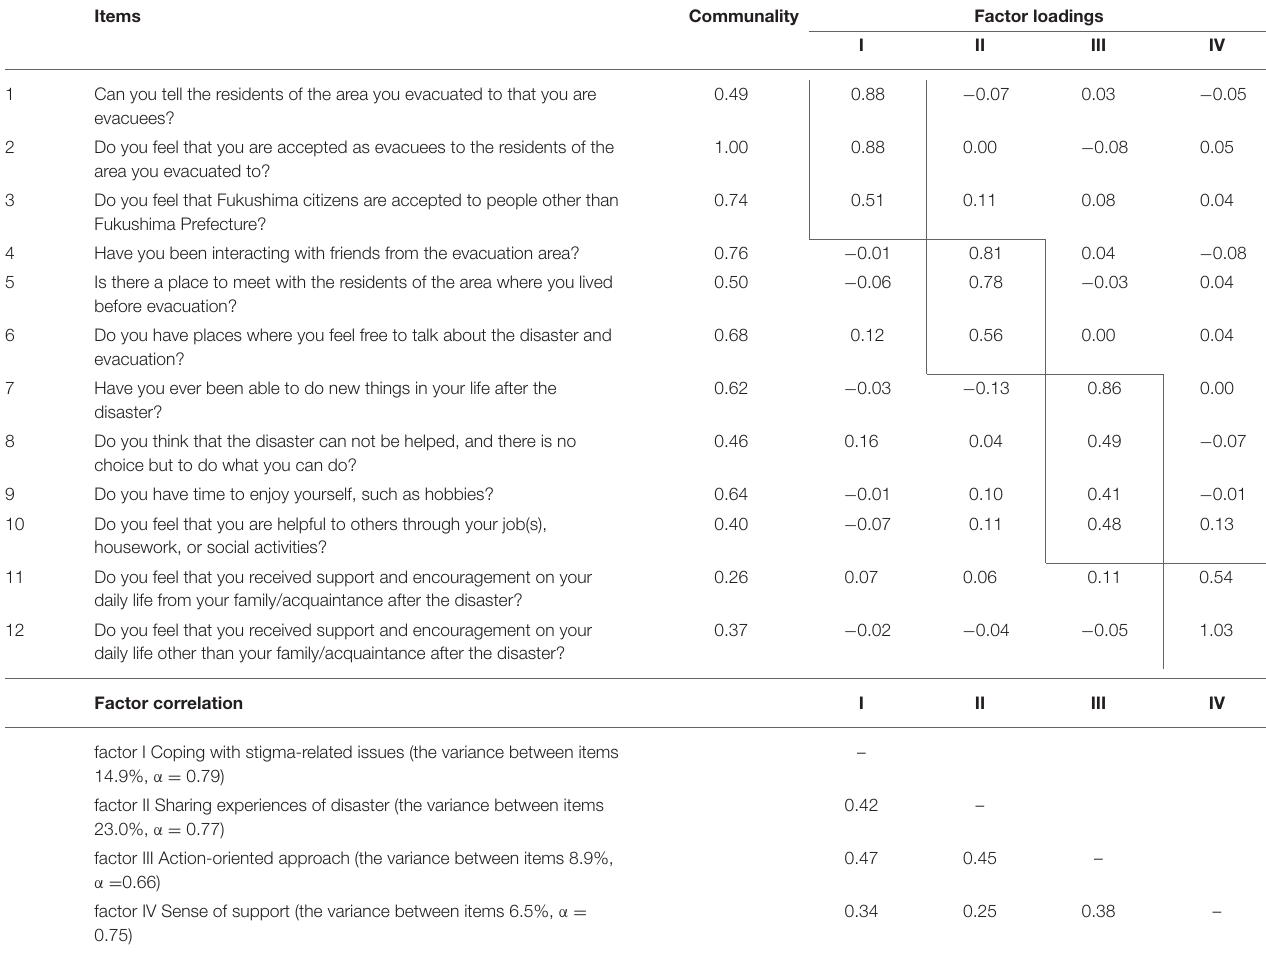
TABLE 3 | Results of exploratory factor analysis of the Fukushima Resilience Scale (FRS).